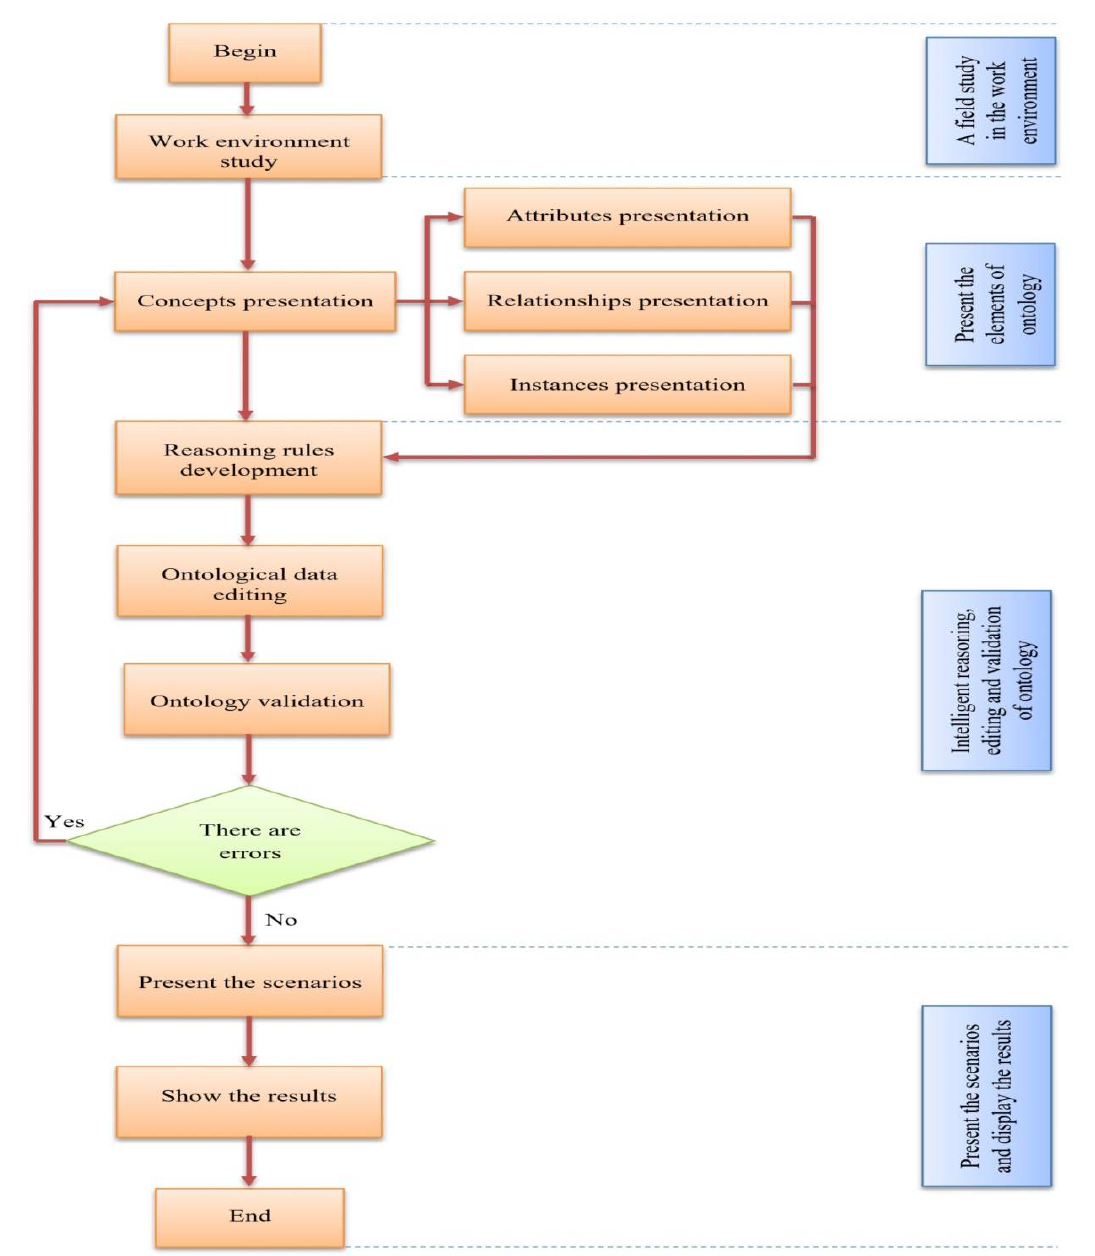
Figure 1. The proposed IRRHEM method.